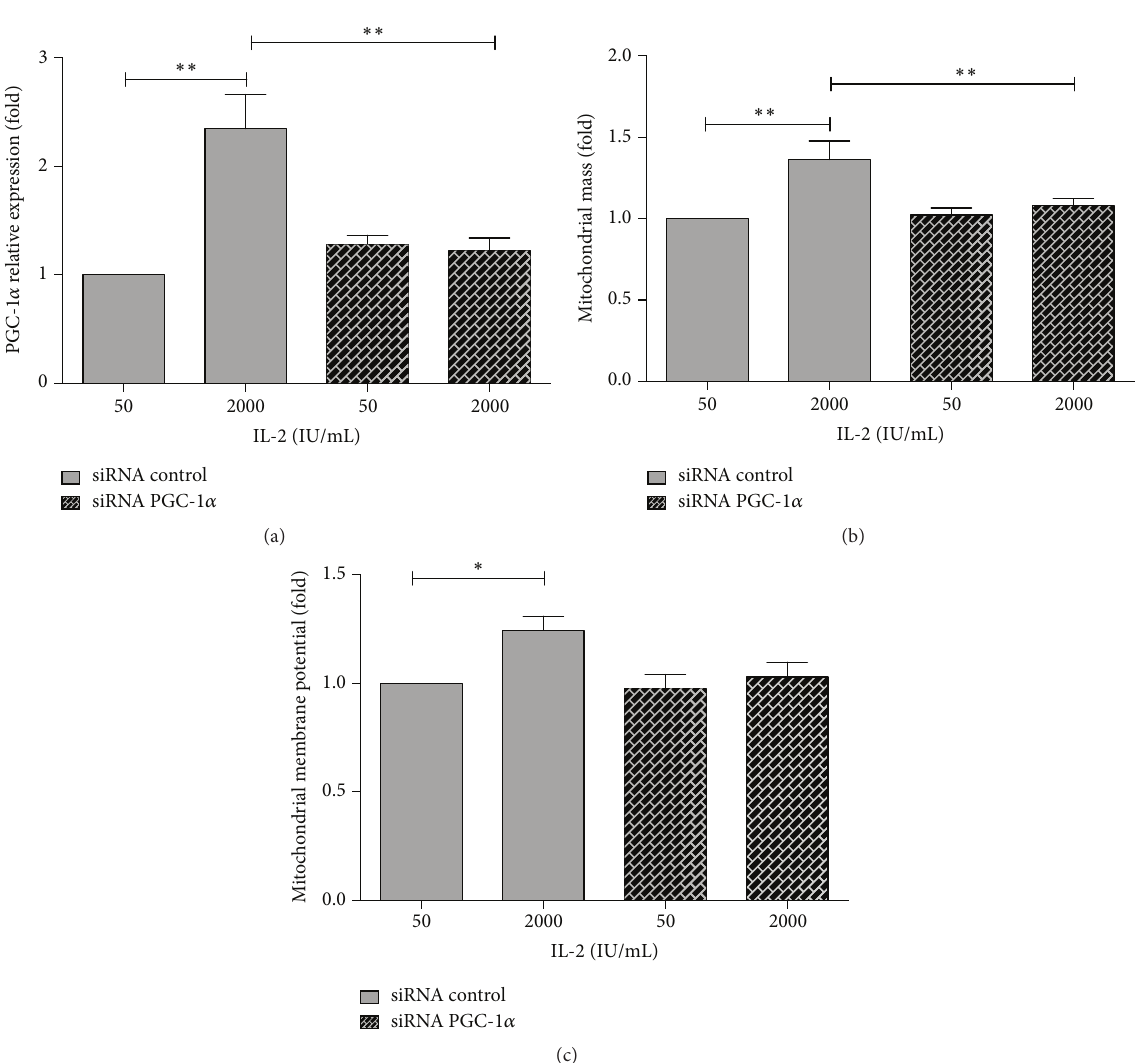
Figure 3: Increase in mitochondrial mass and mitochondrial membrane potential induced by IL-2 is mediated by an increase in PGC-1 𝛼 expression. Purified human NK cells were transfected with siRNA specific for PGC-1 𝛼 or negative controls and then treated with 50 (control) or 2000 (activated) IU/mL of IL-2 for 72 h. (a) PGC-1 𝛼 mRNA expression was determined by qRT-PCR. Relative expression was normalized with control NK cells, and results show the mean of 8 independent experiments ± SE ( ∗ 𝑝 < 0.05 ). (b) Mitochondrial mass. (c) Mitochondrial membrane potential was analyzed by flow cytometry. Data are shown as the mean of fluorescence intensity in cells and normalized against controls (control siRNA and 50 IU/mL IL-2). Results are mean ± SE from 5 independent experiments ( ∗∗ 𝑝 < 0.01